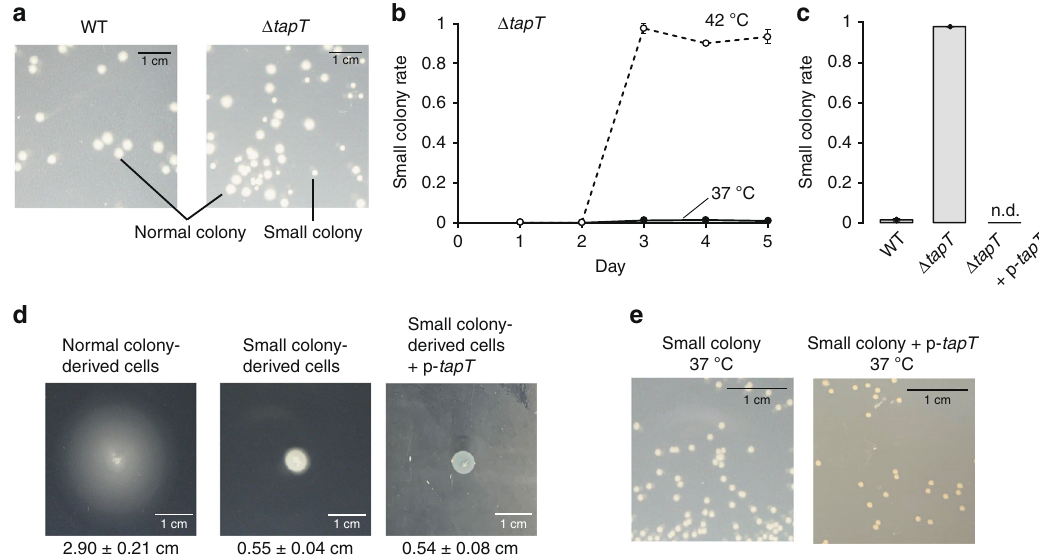
Fig. 3 Lack of acp 3 U47 results in genome instability in E. coli . a Morphological alteration of WT (left) or Δ tapT (right) strains after cultivation at 42 °C for 4 days. Small colonies appeared in the Δ tapT strain. b Frequencies of small colony appearance of Δ tapT strain with continuous cultivation at 37 °C (closed circles) and 42 °C (open circles). Data represent average values of biological triplicates, with s.d. Source data are provided as a Source Data fi le. c Frequencies of small colonies in WT, Δ tapT , and Δ tapT overexpressing tapT after cultivation at 42 °C for 4 days. Data represent average values of biological triplicates, with s.d. Source data are provided as a Source Data fi le. d Motility test of the normal colony-derived cells (left), small colony-derived cells (middle), and small colony-derived cells overexpressing tapT (right). Diameter of halo was de fi ned as the length of the line segment which passes through the center and the ends of the halo. Data represent average values of biological replicates ( n = 5), with s.d. Source data are provided as a Source Data fi le. e Morphology of the small colony-derived cells (left) and the small colony-derived cells overexpressing tapT (right). Overnight saturated cultures were diluted, spotted onto LB plates, and cultivated at 37